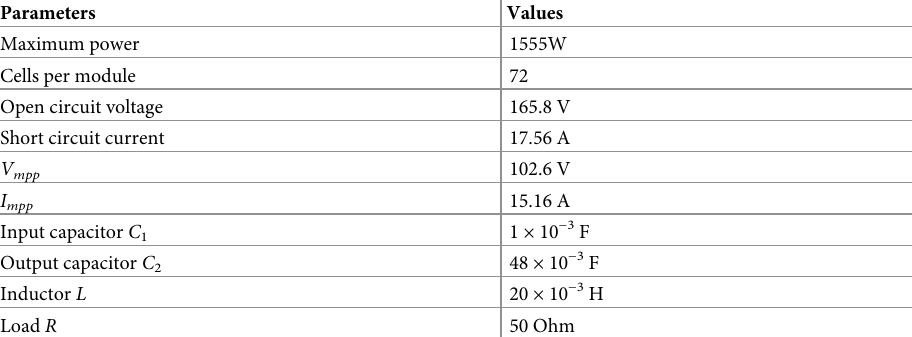
Table 1. PV array parameters and buck-boost converter